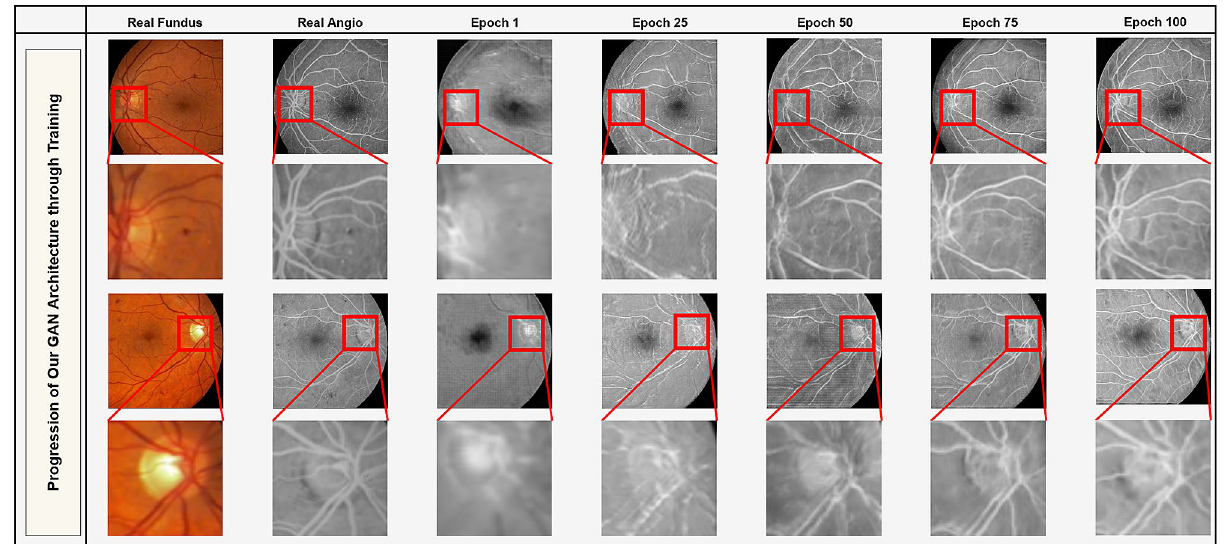
Figure 2. Our proposed method generates more realistic FA images after each epoch as training progresses.